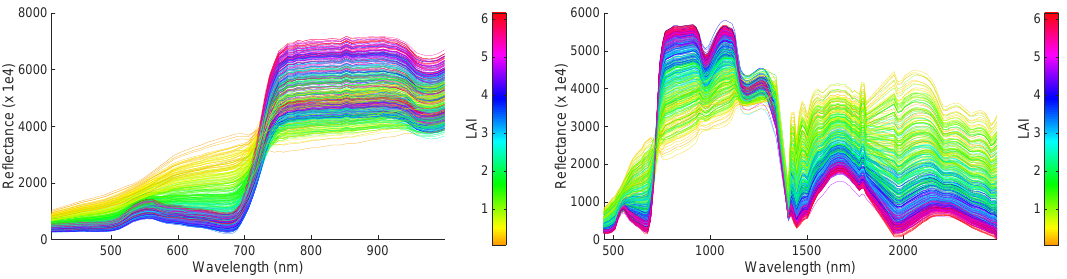
Figure 3. 500 GPR-emulated CHRIS-like ( left ) and HyMap-like ( right ) surface reflectance spectra, color plotted as a function of